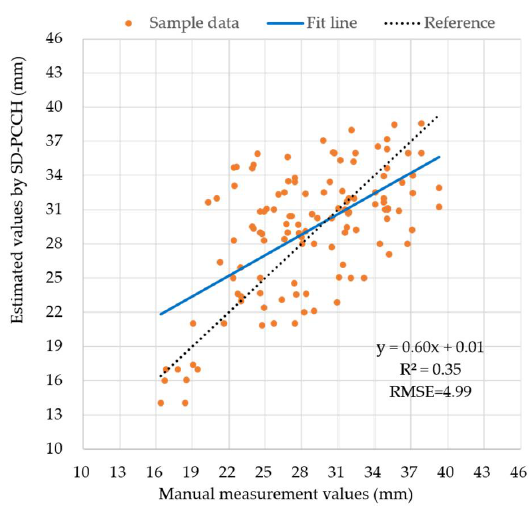
Figure 15. The comparison results of the stem diameter estimation based on SD-PCCH and the manual measurement values.